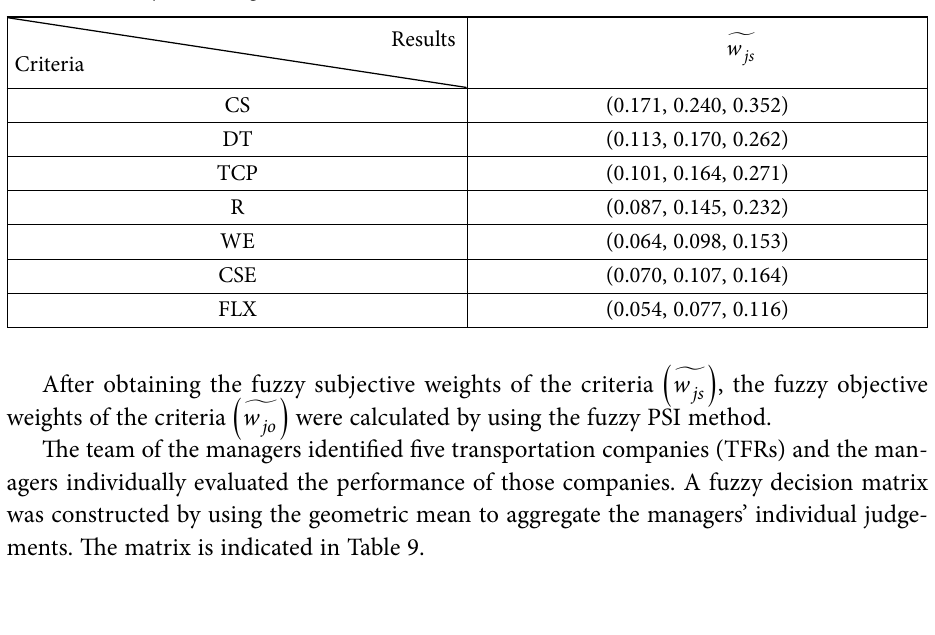
Table 8. The subjective weights of the